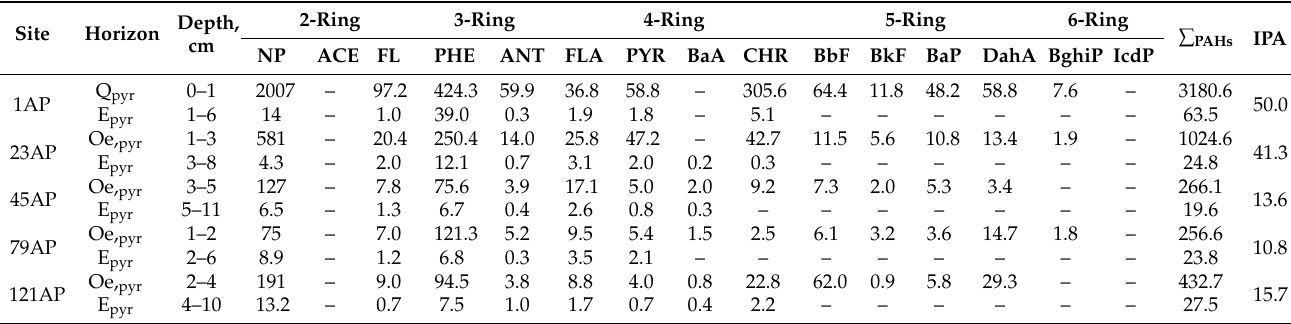
Table 4. PAH content at the upper soil horizons, ng g − 1